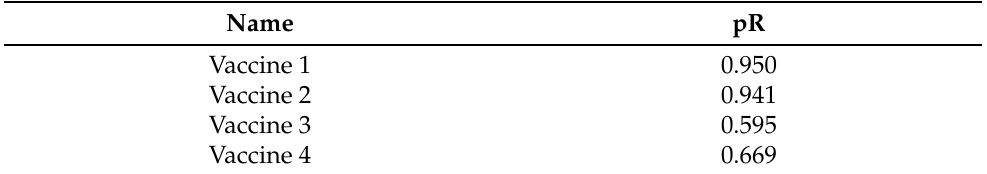
Table 5. Assumed vaccine